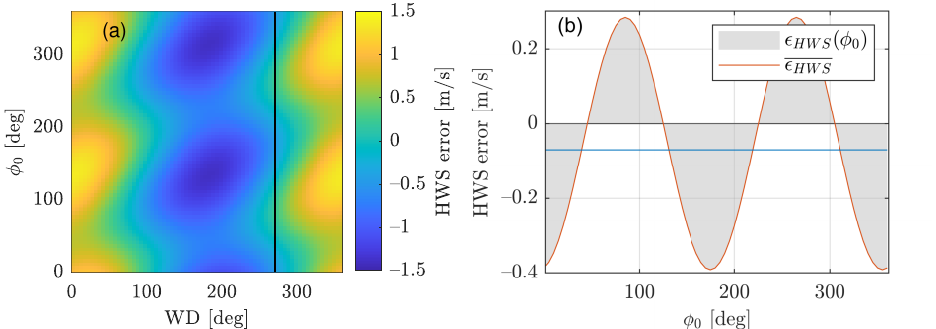
Figure 2. Example of the estimation of the HWS total error in a LiDAR scan ( HWS = 10 m/s, VWS = 0 m/s, and a WD ranging from 0 to 360 deg, roll-only motion). ( a ) Color plot of the HWS error as a function of the wind direction, WD , and initial phase, φ 0 . ( b ) HWS error for WD = 275 deg (vertical black line in panel ( a )) as a function of the initial phase. The blue horizontal line indicates the mean HWS